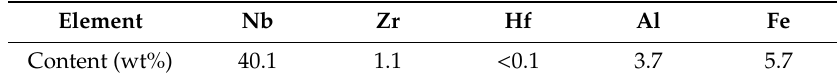
Table 3. Composition of Nb precipitate.